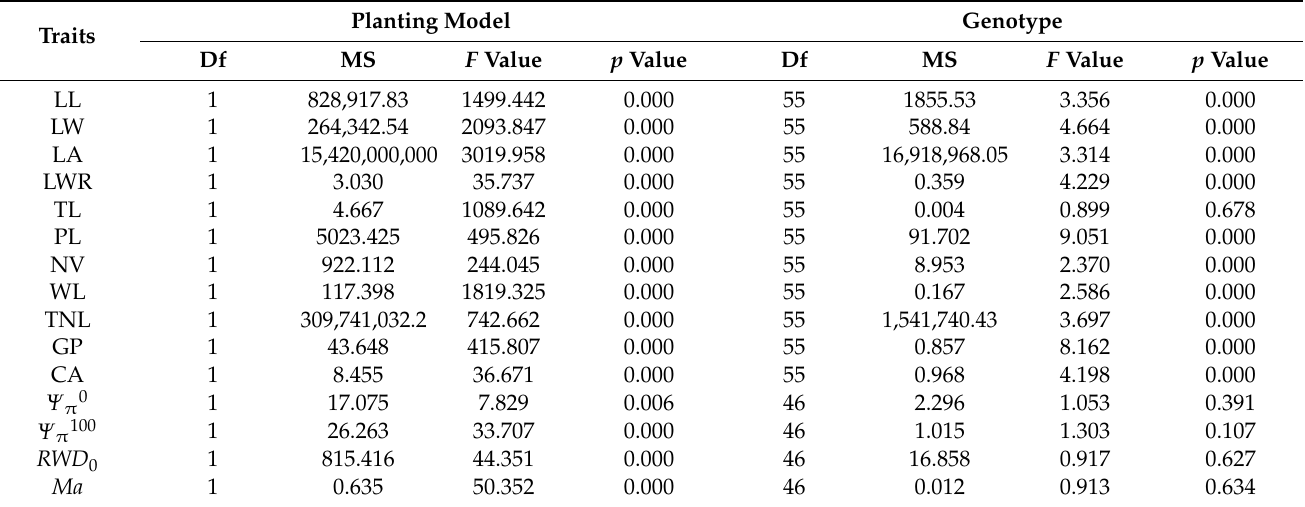
Table 3. Variance analyses of leaf-related traits in different planting models of Eucommia ulmoides Oliver. Planting Traits